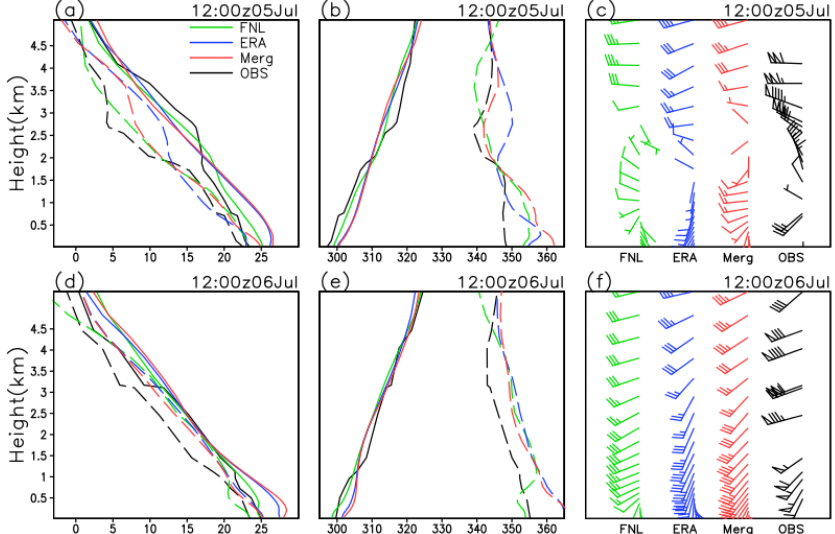
Figure 6. Comparison of the 0~5 km simulated and observed thermodynamic profiles at Nanjing site. ( a ) Temperature (solid line, units: °C) and dew point (dashed line, units: °C); ( b ) potential temperature (solid line, units: K) and equivalent potential temperature (dotted line, units: K); and ( c ) wind barbs are plotted with a full barb of 4 m ⋅ s −1 at 12 p.m. UTC on 5 July; ( d – f ) is the same as ( a – c ), but at 12 p.m. UTC on 6 July.